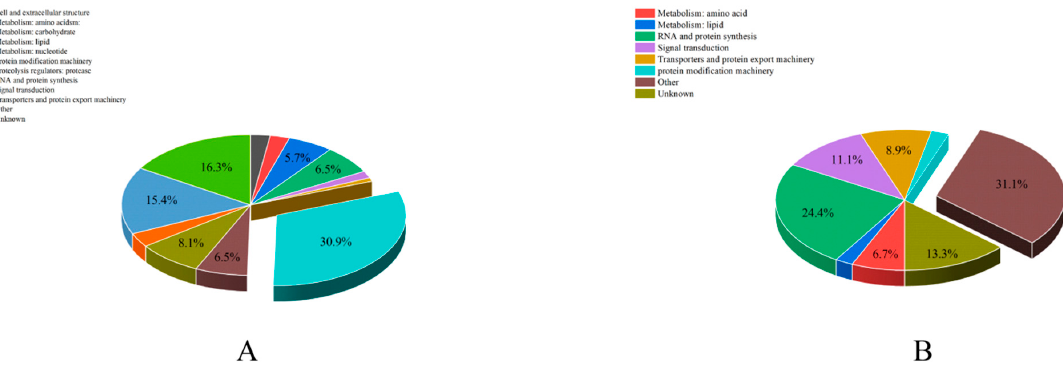
Figure 4. The distribution of functional categories of accessory gland proteins (ACPs) in Plutella xylostella . ( A ) functional category analysis of the predicted secreted ACPs. ( B ) functional category analysis of the unconfirmed ACPs.